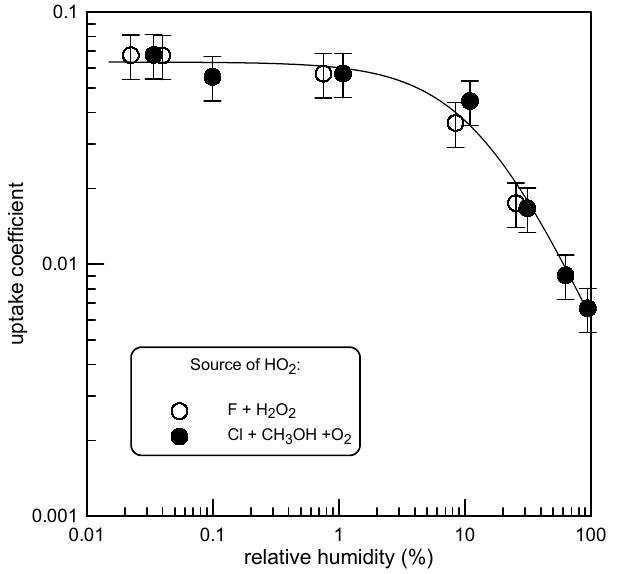
Fig. 6. Initial uptake coefficients of HO 2 on ATD as a func- tion of relative humidity: T = 275K, P = 1 . 0–9.0Torr, [HO 2 ] 0 ≈ 10 12 moleculecm − 3 , sample mass = (1.2–1.5)mgcm − 1 . The data were obtained with two sources of HO 2 radicals: reactions F + H 2 O 2 (open symbols) and Cl + CH 3 OH + O 2 (filled symbols).